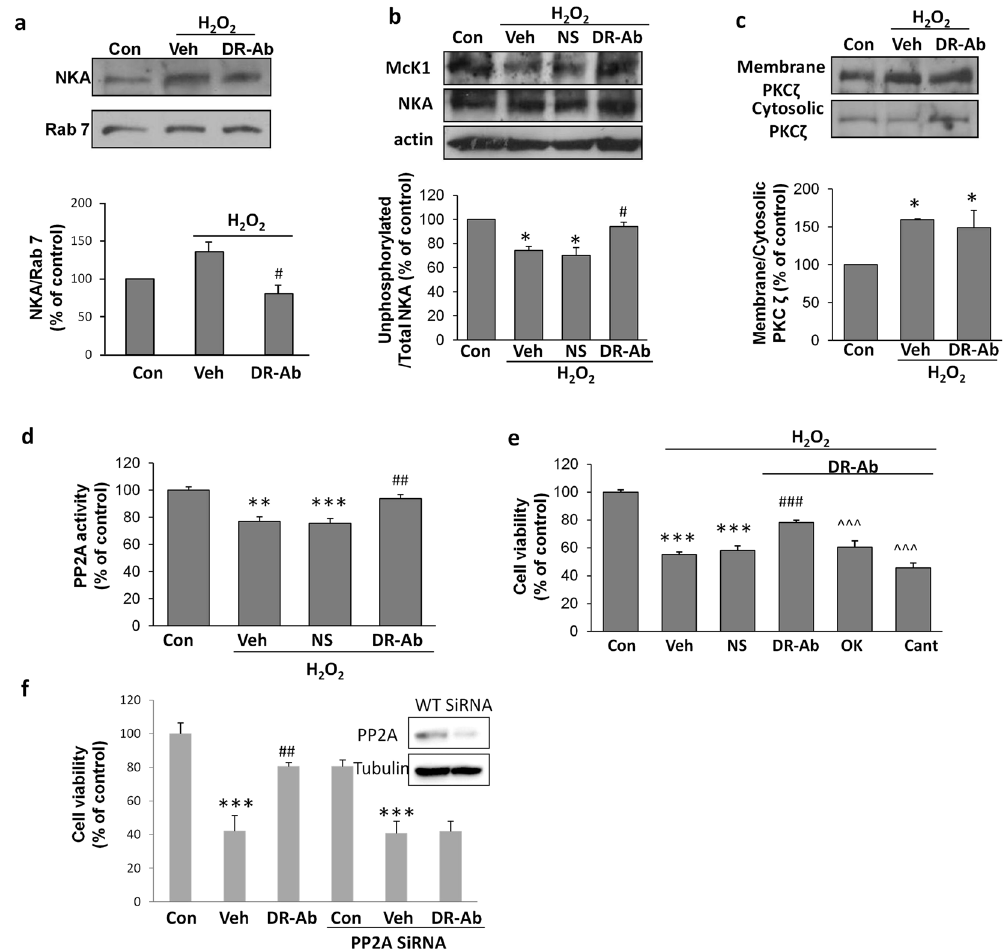
Figure 8. Involvement of PP2A in H 2 O 2 -induced NKA endocytosis and cardioprotective effect of DR-Ab. ( a ) Representative Western blots and group analysis showing NKA in endosomes isolated from cells of different treatment groups. Incubation with 100 µ M H 2 O 2 for 1 hr induced enrichment of NKA in the endosomes. n = 6; ( b ) Representative Western blots and group analysis of McK1 showing the unphosphorylated NKA at Ser18 in H9C2 rat myoblast cell line exposed to 100 µ M H 2 O 2 for 30 min. n = 3; ( c ) Representative Western blots and group analysis of PKC ζ in the membrane and cytosolic fractions of cell lysate. n = 4; ( d ) Effect of H 2 O 2 (100 µ M, 30 min) and DR-Ab (160 ug/ml, 1 h pretreatment) on PP2A activity in AC16 cells. n = 3; ( e ) Effect of PP2A inhibitors, okadaic acid (OK, 100 nM) and cantharidin (Cant, 1 µ M), on the DR-Ab conferred antioxidative protection. n = 8. ( f ) Effect of PP2A silencing on cell viability of AC16 cells under oxidative stress. Insert, Western blots showing protein expression of PP2A. n = 8. Mean ± SEM. * p < 0.05, ** p < 0.01, *** p < 0.001 vs control, # p < 0.05, ## p < 0.01, ### p < 0.001 vs H 2 O 2 treatment group, ^^^ p < 0.001 vs DR-Ab + H 2 O 2 group. Veh: PBS. NS: Normal rat